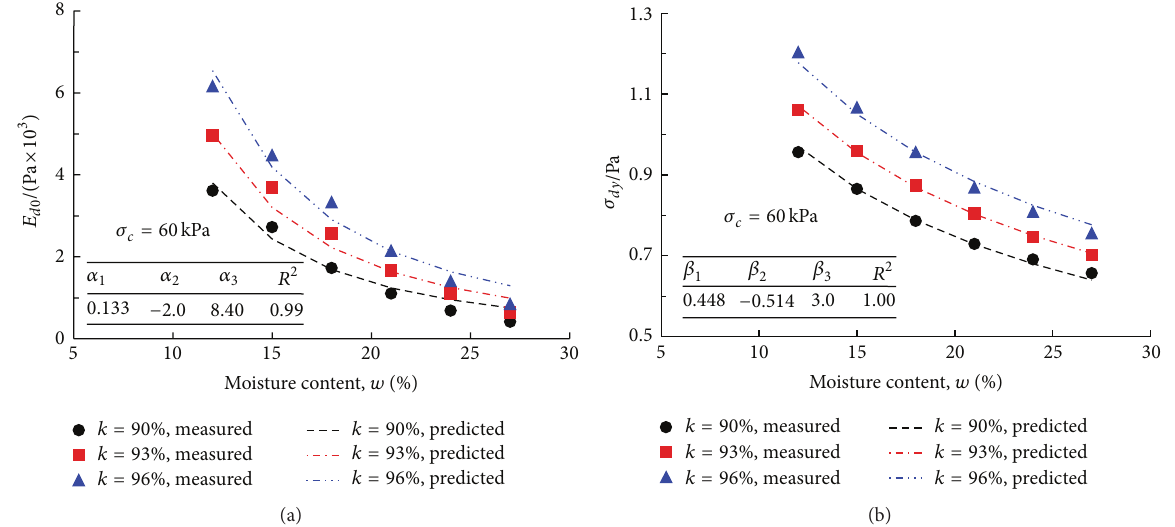
Figure 4: Comparison of lab-measured results and model-predicted values versus moisture content for various degrees of compaction: (a) /( Pa × 10 3 ) ; (b) 𝜎 / 𝐸 𝑑0 𝑑𝑦